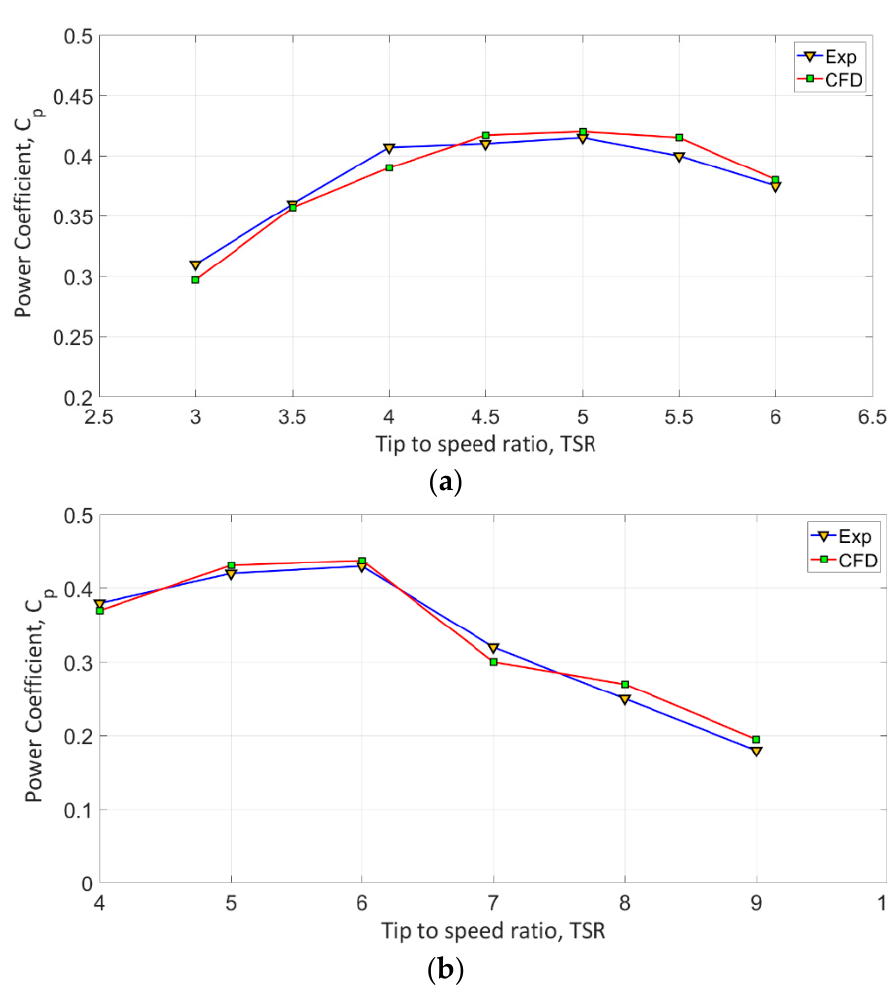
Figure 10. Comparison between CFD results and experimental data from ( a ) [10]; ( b )